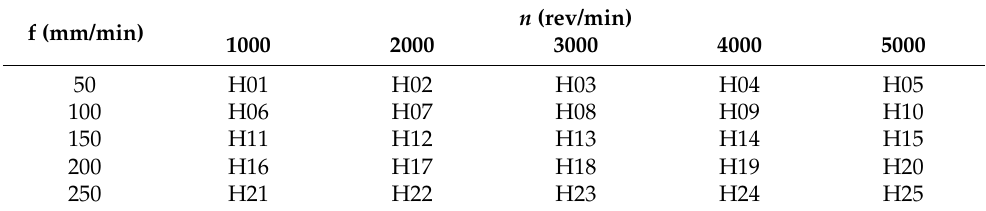
Table 3. Cutting parameters of the validation experiments.